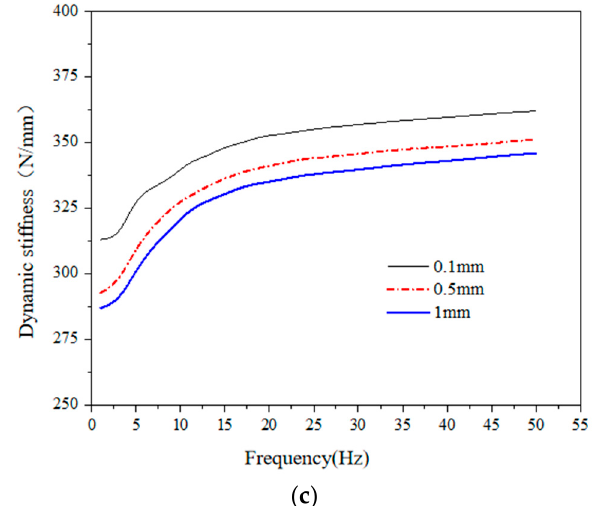
Figure 14. Frequency variation characteristics of suspension main spring. ( a ) non-creep. ( b ) 2.98 mm creep. ( c ) 3.83 mm creep.